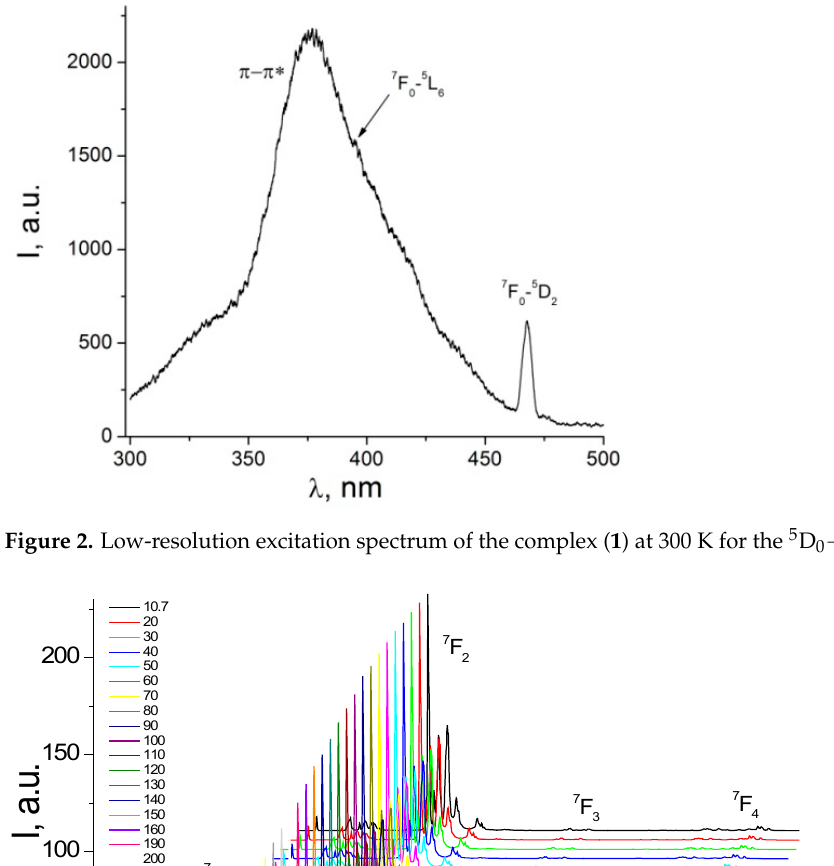
Figure 3. PL emission spectra of the powder sample measured at different temperatures ( λ ex = 405 nm).